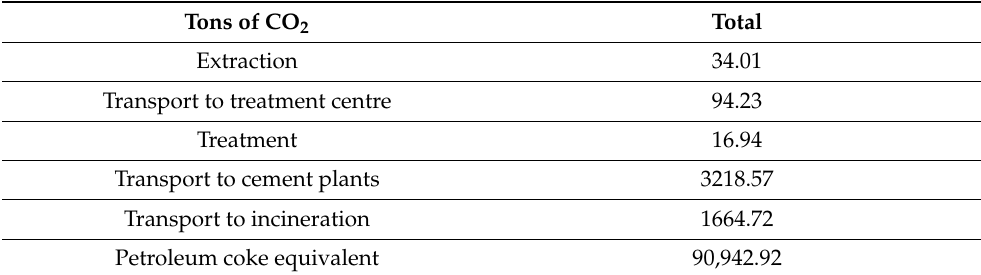
Table 12. Avoided CO 2 emissions